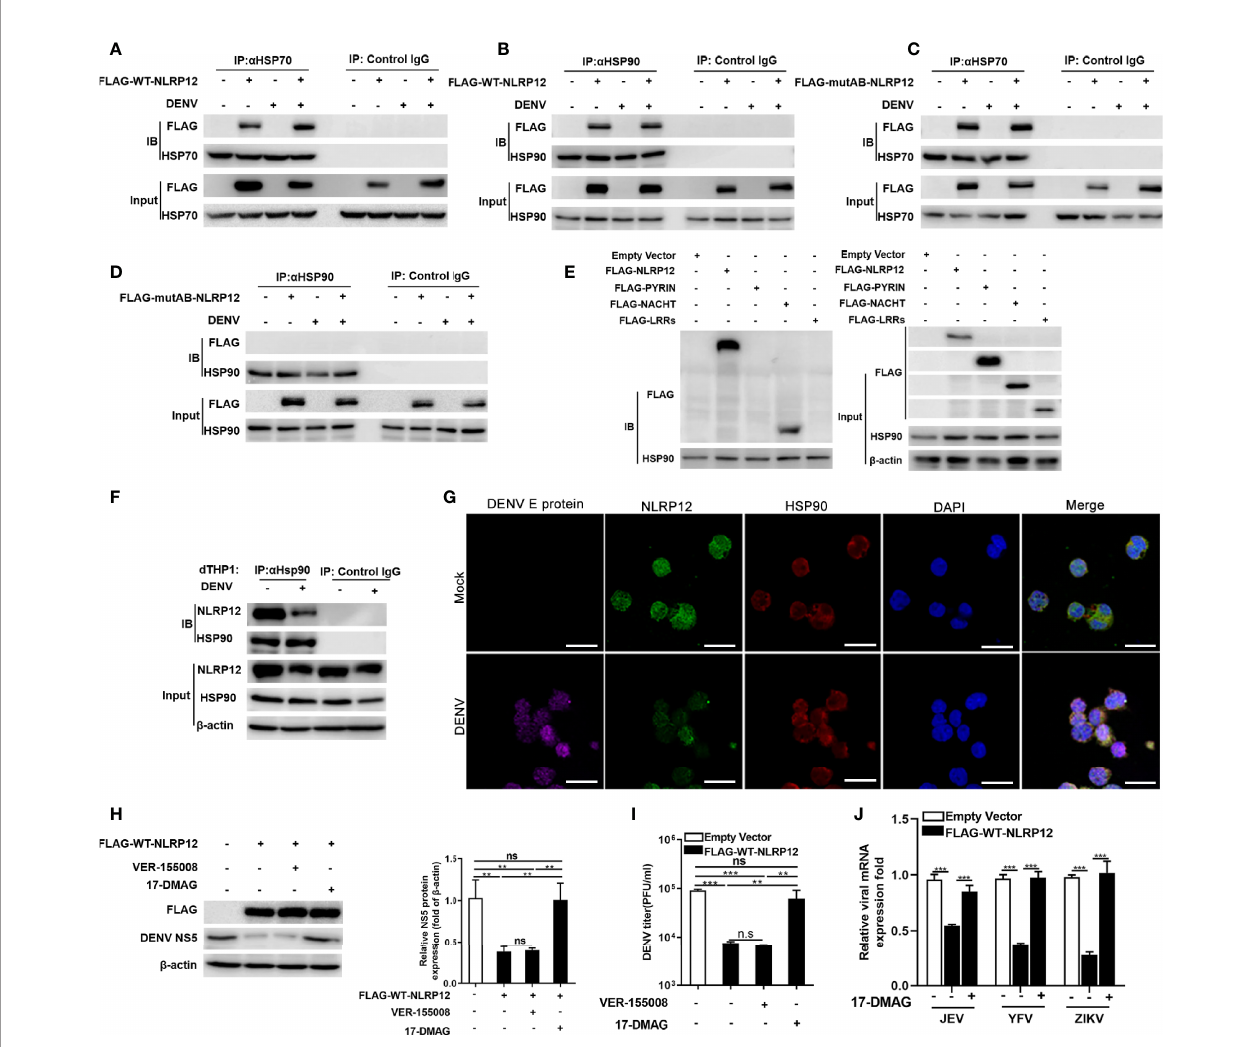
FIGURE 5 | HSP90 interacted with NLRP12 and regulated its antiviral function. (A, B) dTHP1 cells were transfected with FLAG-tagged NLRP12 plasmid and infected with or without DENV at a MOI of 4 for 72h, the interaction between exogenous NLRP12 and endogenous HSP70 or HSP90 was detected by Co-IP. (C, D) FLAG-tagged NLRP12 Walker A/B mutants (mutA, mutB and mutA+B) were transfected into dTHP-1 cells, and the cells were infected with or without DENV at a MOI of 4 for 72h, the interaction between mutated NLRP12 and HSP70 or HSP90 was detected by Co-IP. (E) The plasmids carrying the Flag-tagged full length and three truncations were transformed into dTHP1 cells, after which the cells were collected to detect the interaction between HSP90 and exogenous NLRP12 and its truncations by Co-IP. (F) dTHP1 cells were infected with or without DENV (MOI: 4) for 72h. Cells were lysed by RIPA lysis buffer and immunoprecipitated complexes were collected using protein A/G plus agarose beads and analysis by western blotting. (G) dTHP1 cells were infected with or without DENV (MOI: 4) for 72h. Immuno fl uorescence staining was performed for DENV E protein, NLRP12, PRDM1 and DAPI and cells were imaged using confocal microscopy (Bar: 10 m M). (H, I) NLRP12-transfected dTHP-1 cells were treated with HSP70 inhibitor VER-155008 or HSP90 inhibitor 17-DMAG, the treated cells were infected with DENV at a MOI of 4 for 72h, and the protein level of NS5 was detected by western blot and NS5 protein bands were analyzed by Image J gel image analysis software and normalized to b -actin. The viral titer of supernatant samples was measured by plaque assays. (J) NLRP12 overexpressing dTHP-1 cells were treated with HSP90 inhibitor 17-DMAG, cells were then infected with JEV, YFV and ZIKV separately, virus genes were fi nally detected using quantitative qPCR. Each experiment was repeated a minimum of three times and the statistical signi fi cance was determined with analysis of one- way analysis of variance (ANOVA). ns, non signi fi cant, **p < 0.01, ***p <